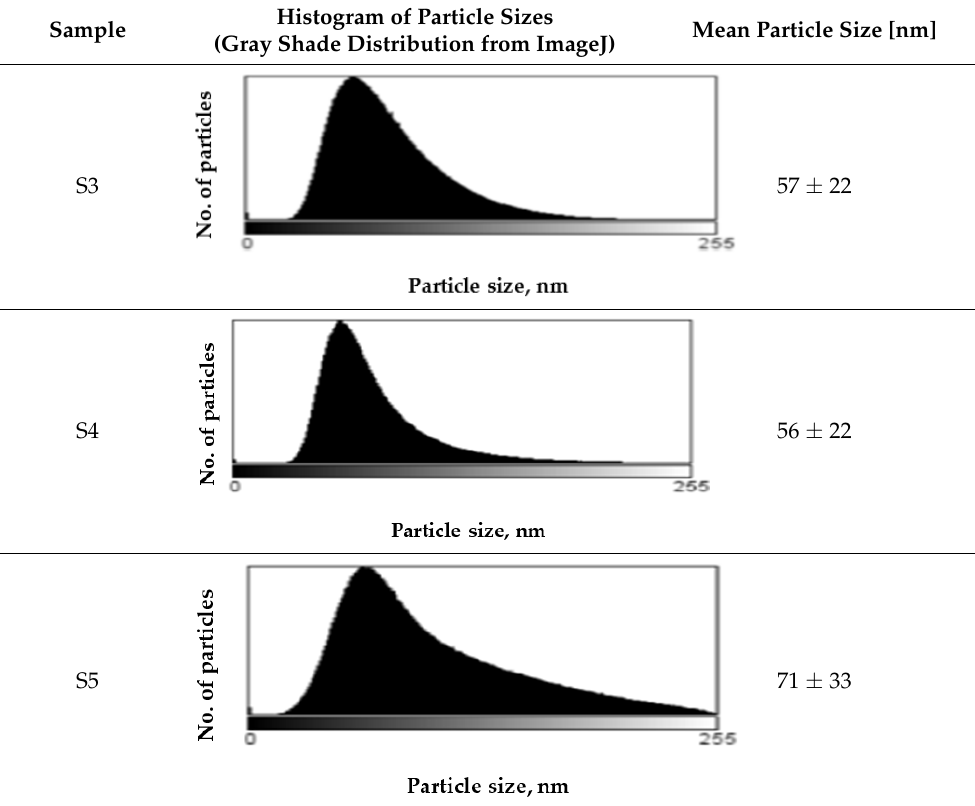
Histogram of Particle Sizes Sample (Gray Shade Distribution from ImageJ)